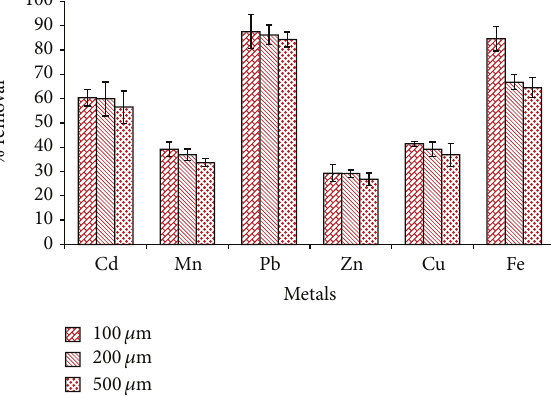
Figure 8: Effect of pH on metal removal using morula nut shells (MNS) while keeping other conditions constant.